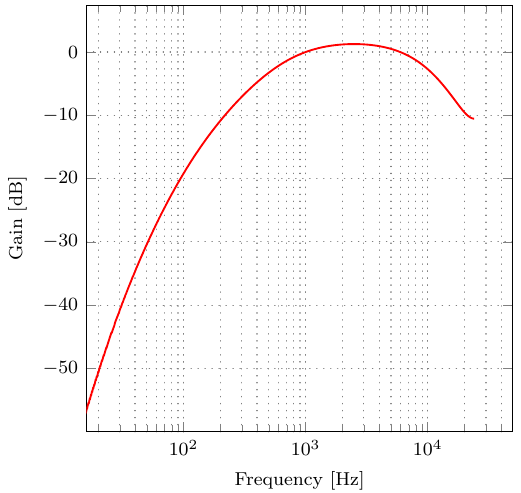
Figure 1. Magnitude response of the analog A-weighting filter given by